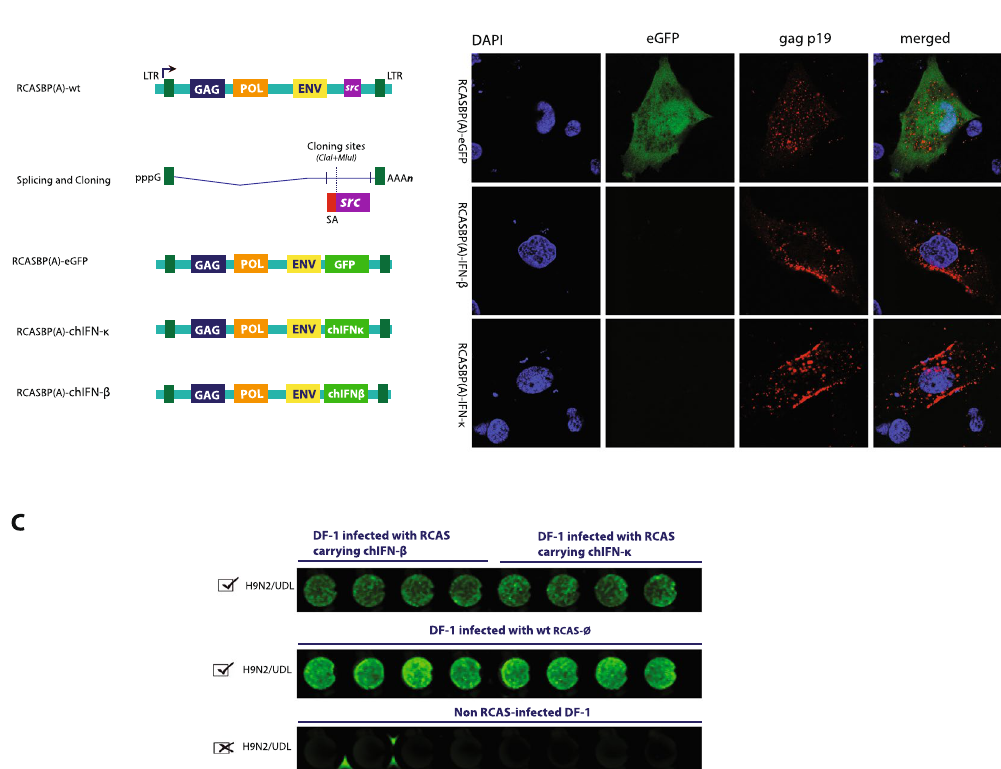
Figure 5. Construction and rescue of chIFN- κ , chIFN- β and GFP expressing recombinant RCASBP(A) viruses. ( A ) Schematic illustration of the proviral DNA, and viral genes (gag, pol, env and src). The expression of transgenes is initiated by the viral LTR. Host DNA-dependent RNA polymerase transcribes viral mRNA that is capped (indicated by pppG) and polyadenylated (AAAn) at their 5 ′ and 3 ′ ends, respectively. Foreign genes of length lesser than 2.8 kb can be cloned between ClaI and MluI sites that replace most of the src gene. The expression of the foreign gene is mediated via the src splice accepter (SA). Construction of RCASBP(A)-eGFP, RCASBP(A)-chIFN- κ and RCASBP(A)-chIFN- β was performed by replacing src gene with GFP and chIFN- β and chIFN- κ cDNA, respectively. ( B ) Stable cell lines constitutively expressing either eGFP (upper panel), chIFN- β (middle panel) or chIFN- κ (lower panel) were stained for RCASBP(A) viral structural protein, gag , to demonstrate the effective rescue and replication of the viruses. ( C ) DF-1 cells stably expressing RCASBP(A)- delivered chIFN- β and chIFN- κ were infected with an moi 1 of AIV (UDL/08/H9N2). Cells were then stained for the AIV-specific NP antibodies to demonstrate the chIFN- β and chIFN- κ mediated